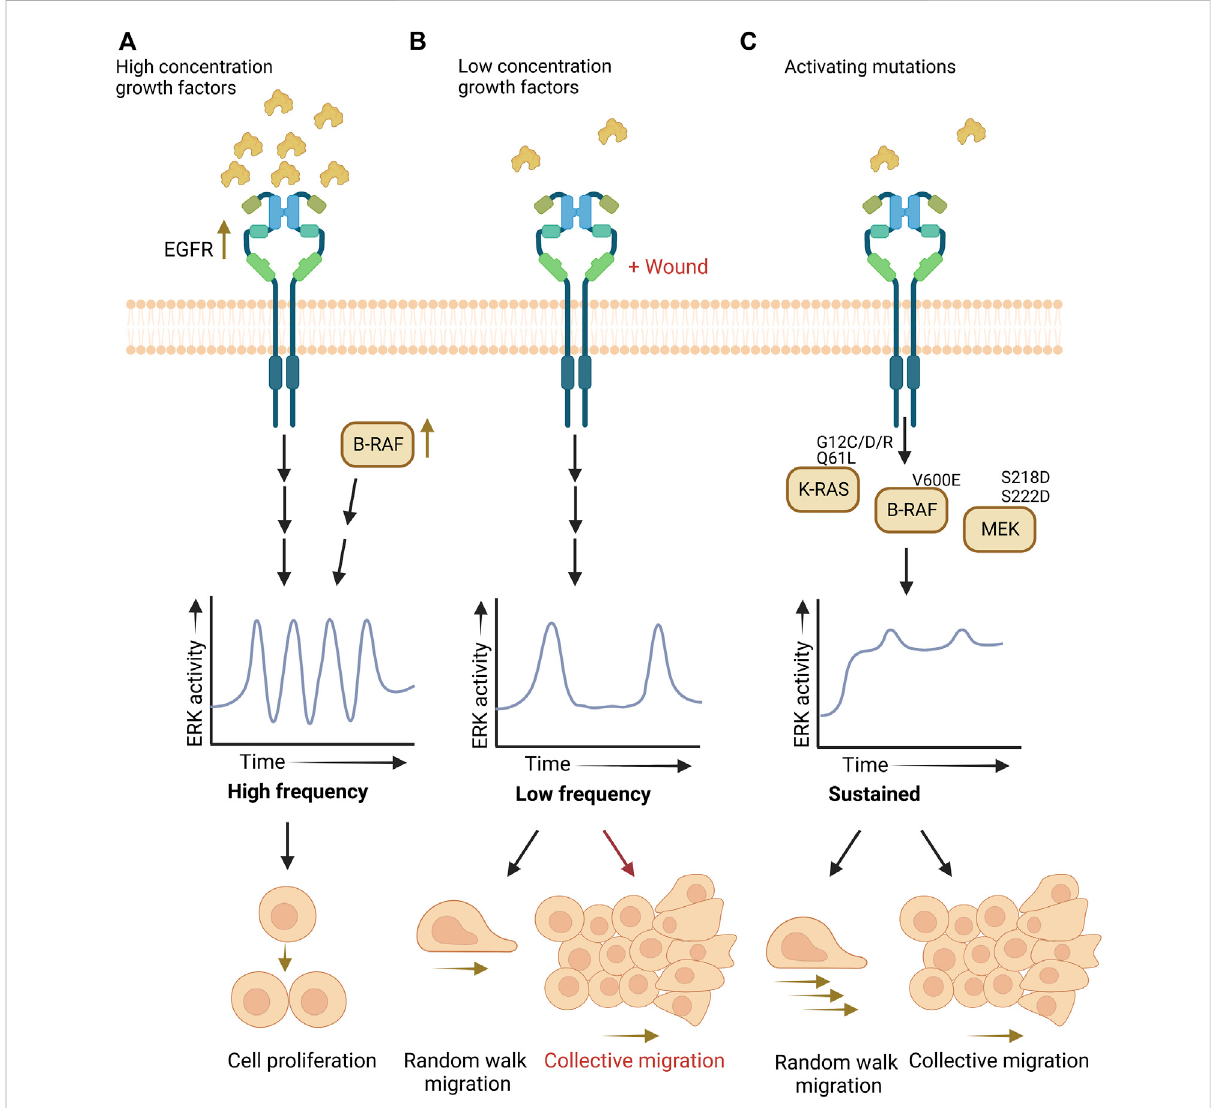
ERK activity patterns dictate cell proliferation versus migration. (A). High-frequency activity pulses promote proliferation. (B). Low-frequency pulses allow random walk migration, and collective migration when also stimulated by wounding. (C) . Activating mutations in RAS/RAF/MEK induce sustained ERK activity and promote random walk and collective